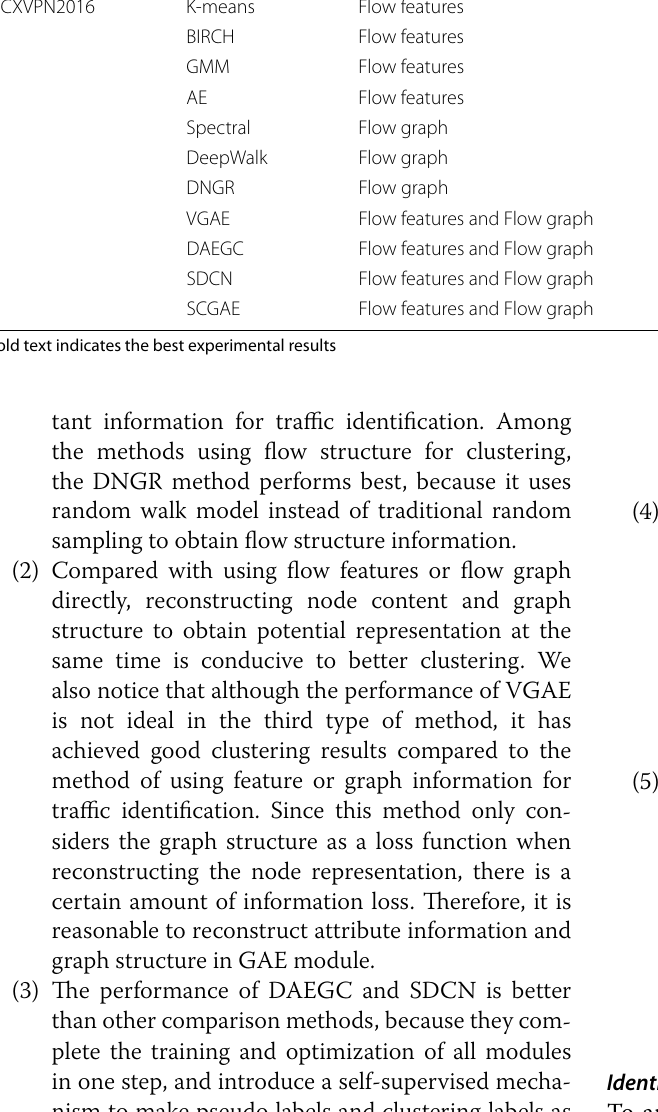
Bold text indicates the best experimental results